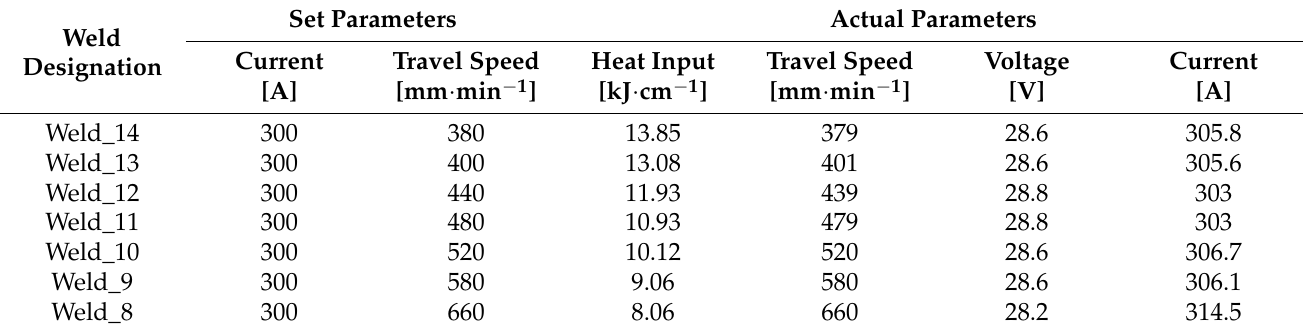
Figure 4. Locations of welds and areas for the metallographic scratch patterns. Table 3. Set and actual process parameters of the individual types of welds.